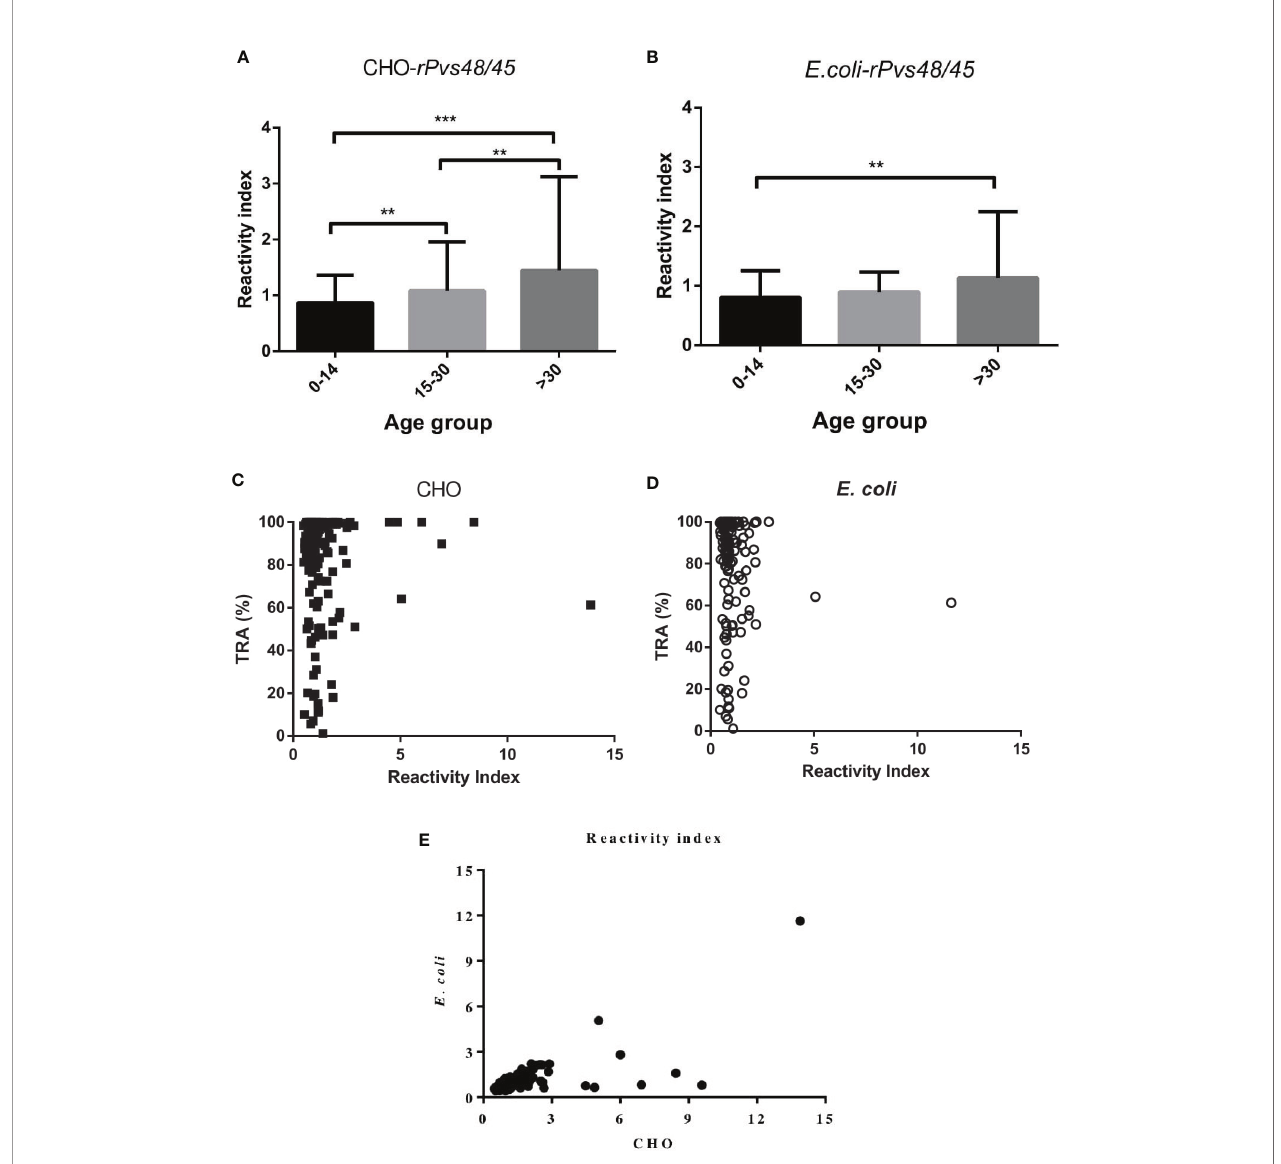
FIGURE 2 | Age-dependent reactivity index (A, B) , and correlation between percentage inhibition in oocyst density (%TRA) of human sera and reactivity index of COL and GUA (C, D) to rPvs 48/45 expressed in both CHO ( A, C) and E. coli (B, D) . (A, B) the bars and error bars correspond to mean values and 2SD. Statistical signi fi cance was observed between each age group in both proteins ( p < 0.0001) by Kruskal Wallis analysis followed by Dunn ’ s multiple comparison tests between two groups. Bars indicated signi fi cant difference between groups of 0-14 and >30 years of age (*** p < 0.0001; ** p < 0.05). (C, D) show no correlation between % TRA and RI (CHO protein p >0.28 and E. coli p > 0.63) by Spearman tests. (E) A dot blotting chart showing the reactivity index of each sera for both